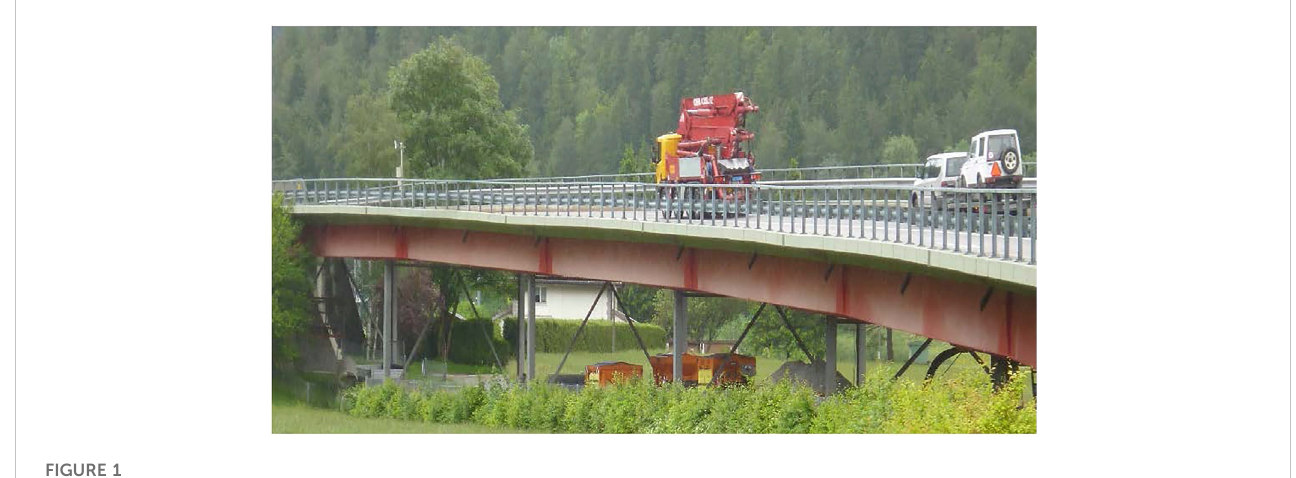
FIGURE 1 The composite steel-concrete bridge case study in Switzerland.